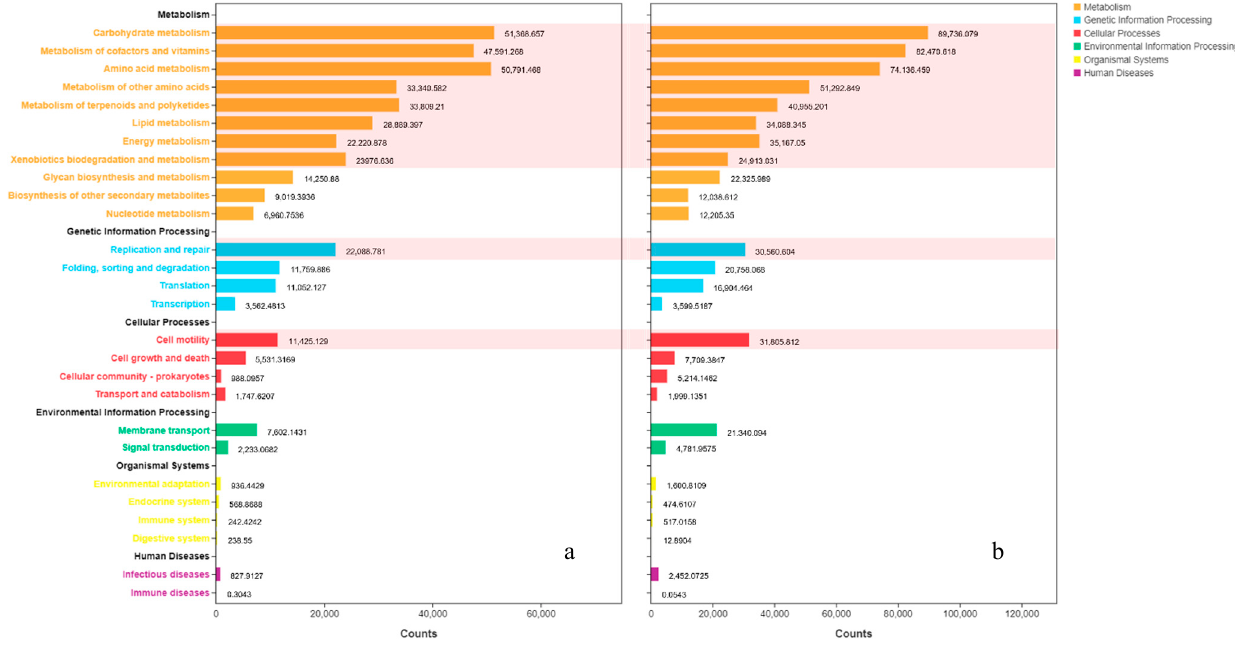
Figure 7. Function distribution bar chart of gene in C-0-D0 ( a ) and C-0-D12 ( b ) (different abundance of function was marked in the background). Table 3. The different abundance of function